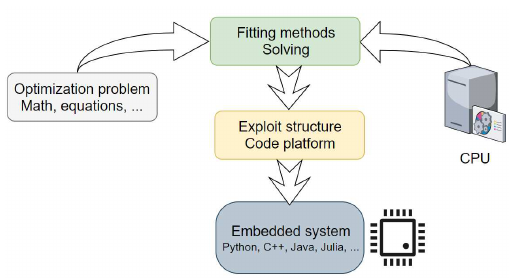
Figure 2. The diagram of embedded optimisation system in UAV- enabled communication.